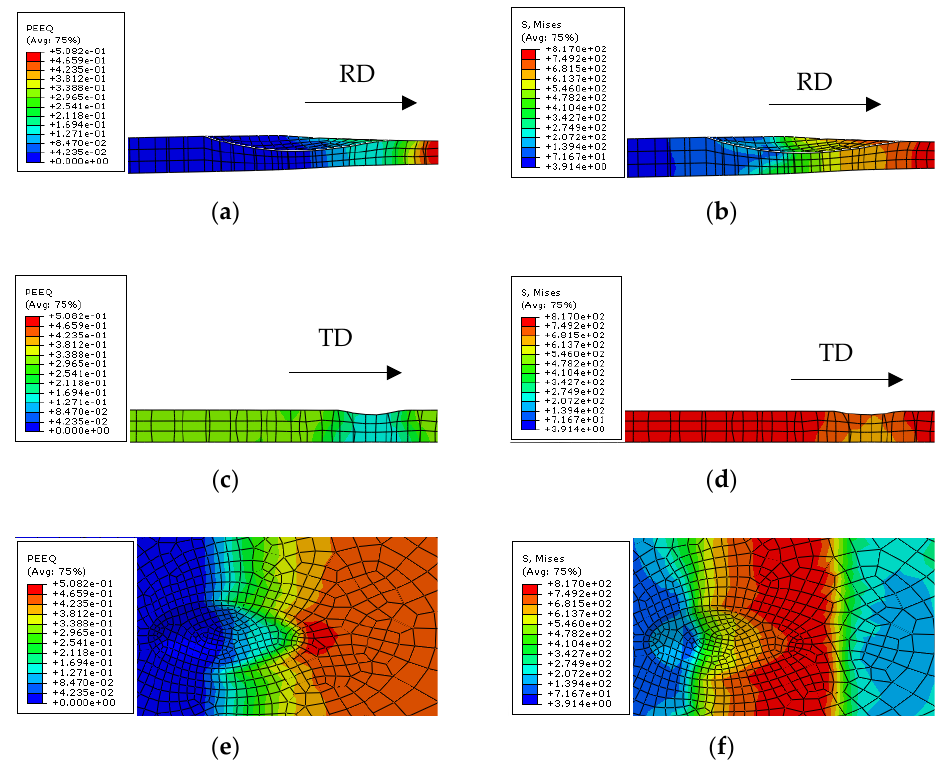
Figure 5. Stress-strain cloud diagrams of the deformation zone in first-pass rolling of strip with 1.5 mm grinding depth. Rolling direction (RD) ( a ) strain and ( b ) stress in cross section; transverse direction (TD) ( c ) strain and ( d ) stress in cross section; ( e ) stress and ( f ) strain cloud diagrams of ground pit in the deformation zone.